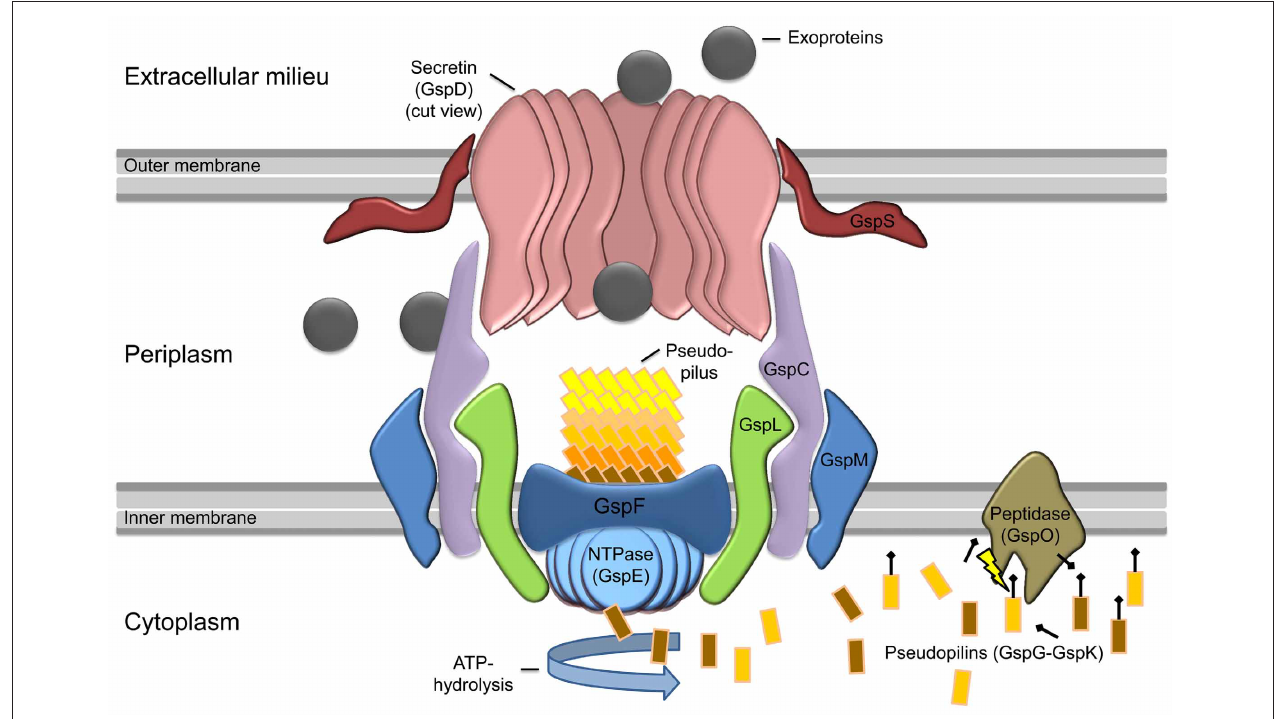
FIGURE 1 | Model of general type II secretion as proposed by Douzi et al. (2012). Exoproteins (gray circles) are initially translocated over the inner membrane (IM) into the periplasmic space via the Sec or Tat pathway (not shown). The prepilin peptidase GspO processes the pseudopilins (GspG–GspK) by cleavage of the leader peptide. The cleaved pseudopilins are then assembled by ATP hydrolysis of the cytosolic NTPase (GspE) to form the pseudopilus. GspE is anchored to the inner membrane by GspL and thereby